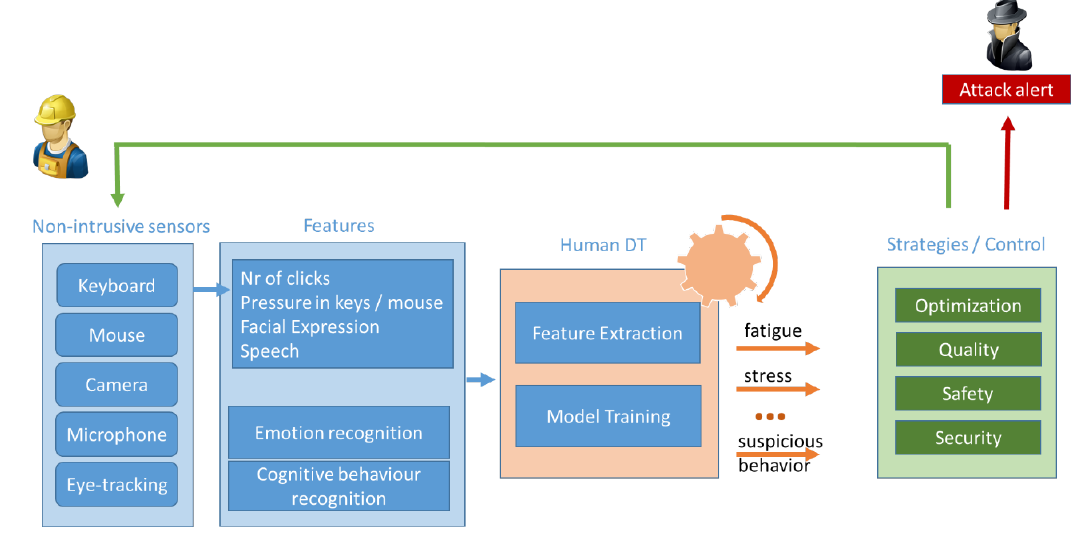
Figure 4. Human Digital Twin Concept.